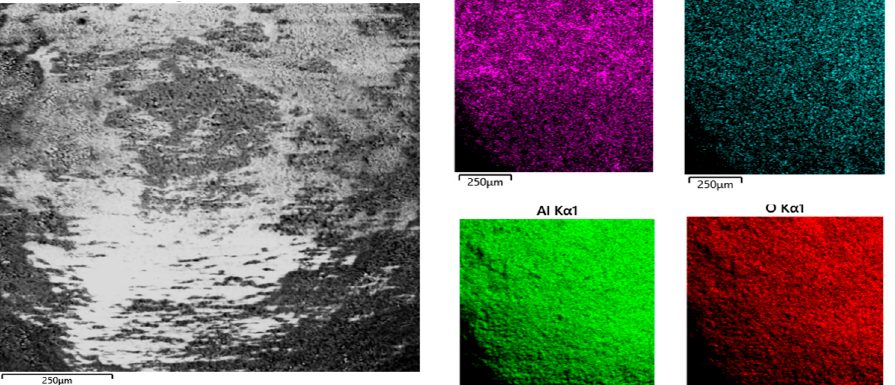
Figure 5. SEM-EDX Ru,Rh- γ Al 2 O 3.